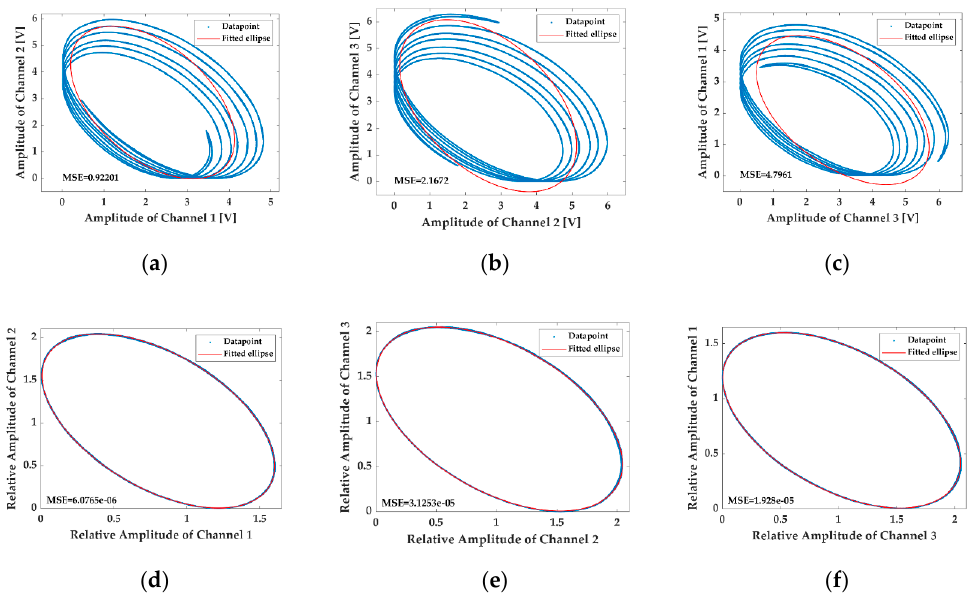
Figure 8. The LFs drawn with the interferometric signals on the FM condition of f m = 1000 Hz and C = 12 before ( a – c ) and after ( d – f ) removing the influence of AAM by the proposed method.